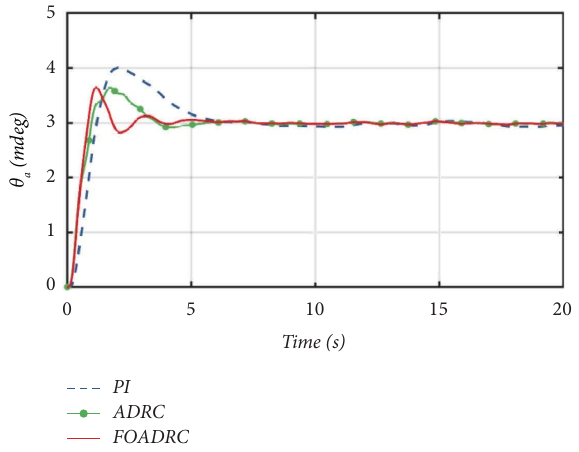
Figure 17: Te step responses for three controllers. Table 1: Te dynamic performance of three controllers.